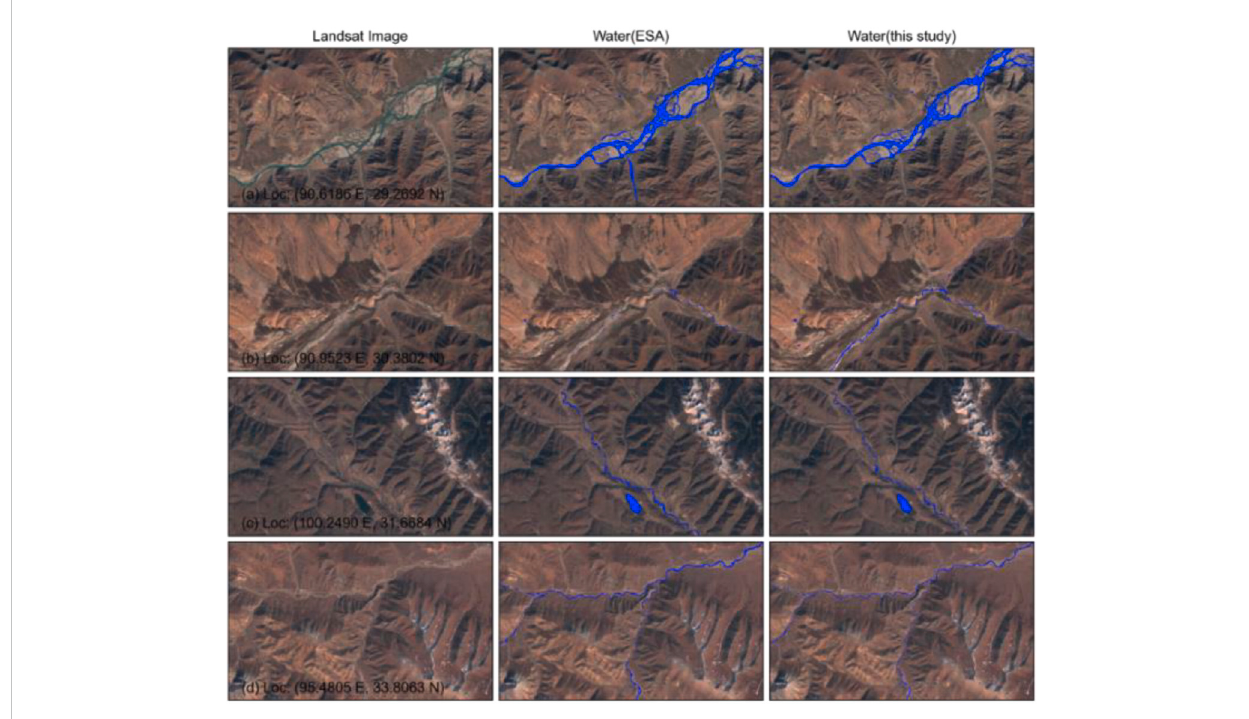
FIGURE 6 Comparisons the water extraction results of this study and ESA water. (A-D) is the different location of the QTP.